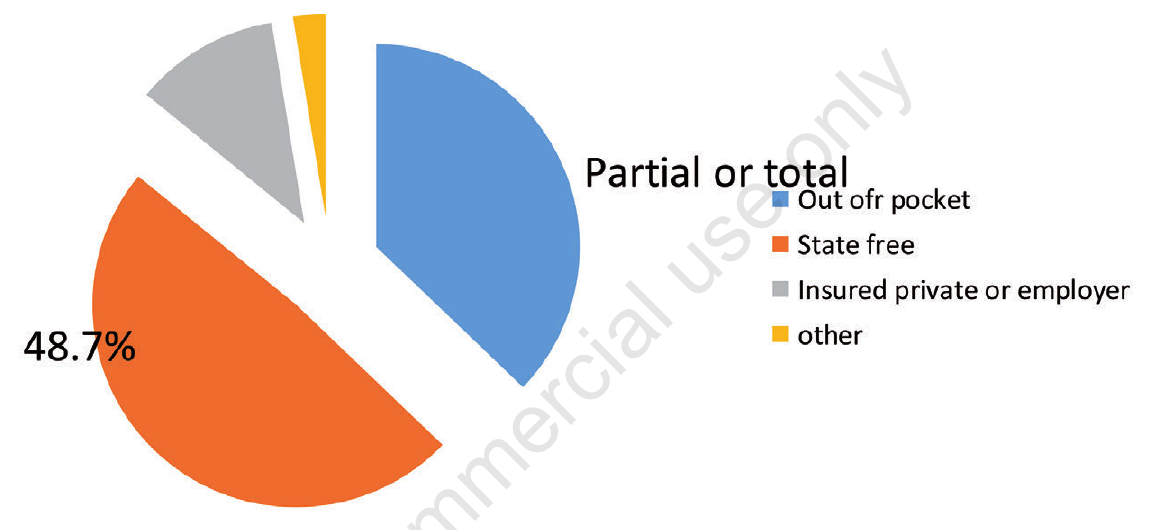
Figure 3. Availability of partial or total healthcare coverage according to country HDI classification.